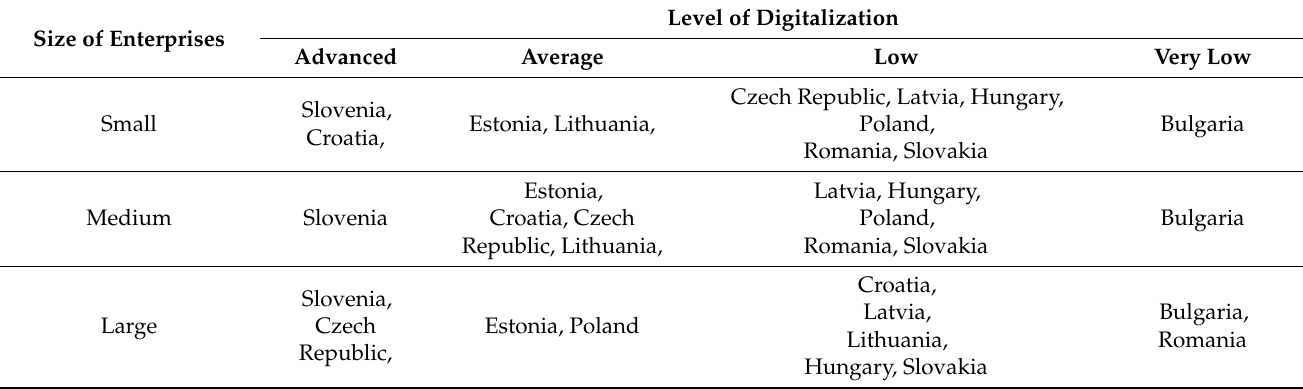
Table 11. The level of CEE countries in terms of digitalization of their enterprises.